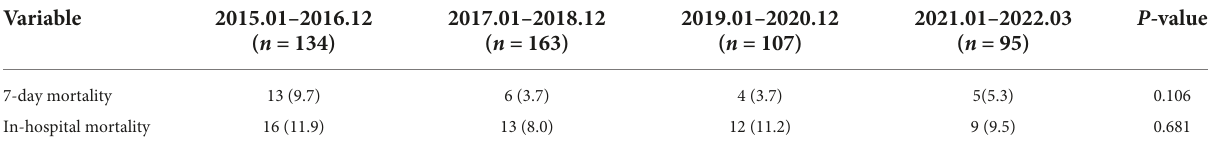
TABLE 6 The 7-day and in-hospital mortality of patients in different